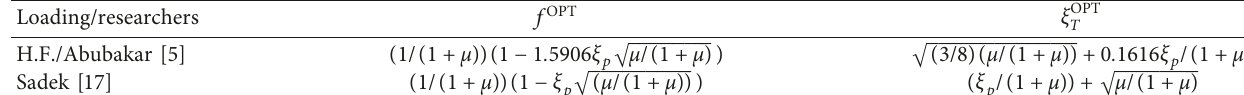
Table 2: Optimal TMD parameters for damped primary structures.